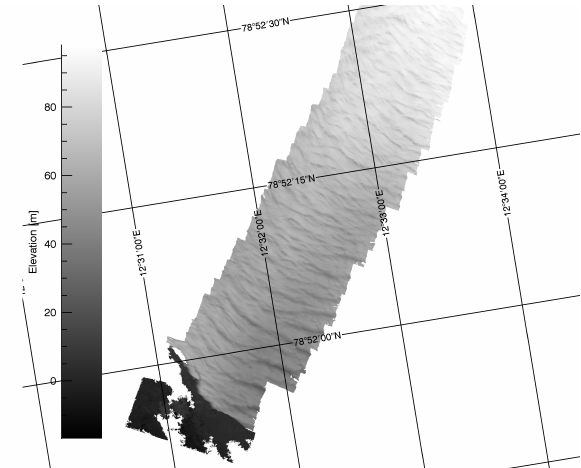
Figure 4: Elevation model from the terminus zone of the Krone- breen glacier. Produced from the Canon EOS 540D with Agisoft PhotoScan pro software utilizing the aircraft position and attitude as auxiliary data. Note that the DEM only cover a small strip around the glacier center line.